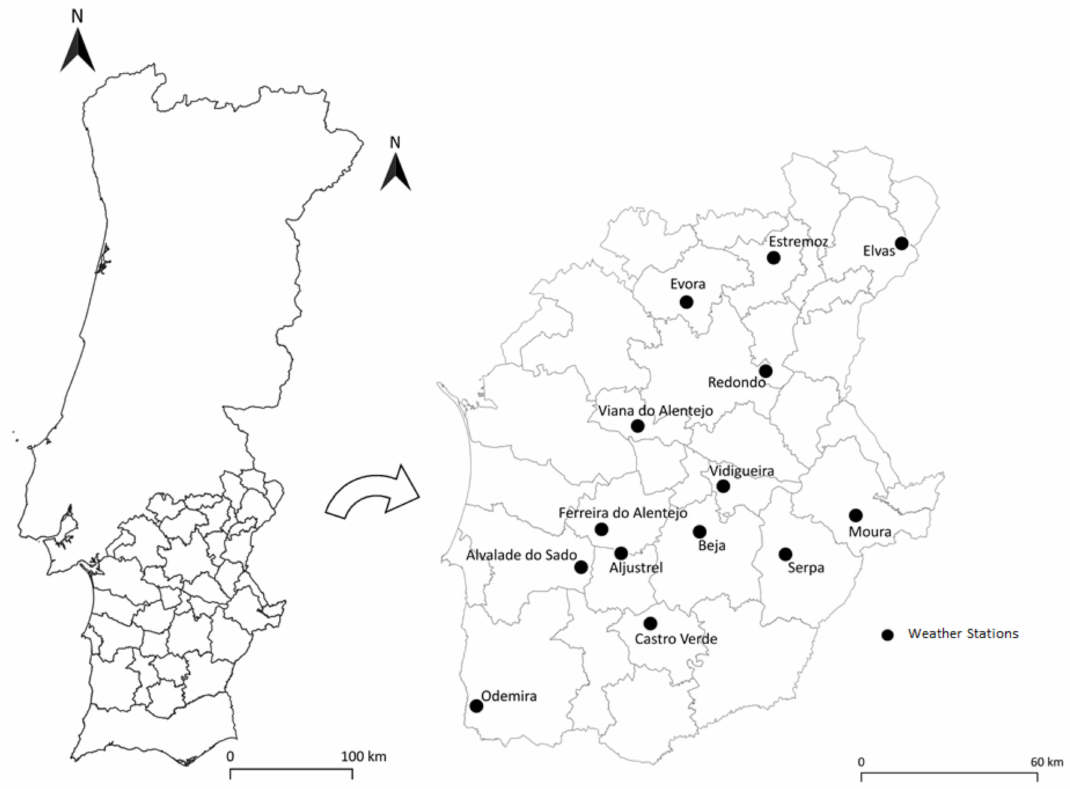
Figure 1. Weather station locations in the Alentejo region of